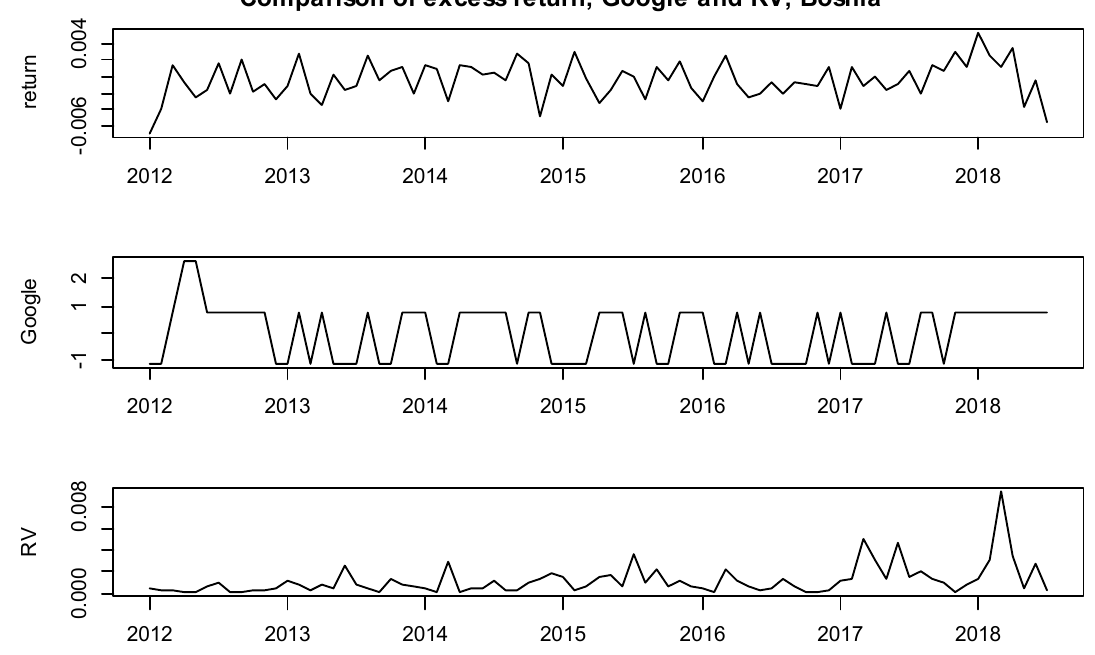
Figure A5. Comparison of monthly series: Excess return, RV and Google search volume, Bosnia and Herzegovina.